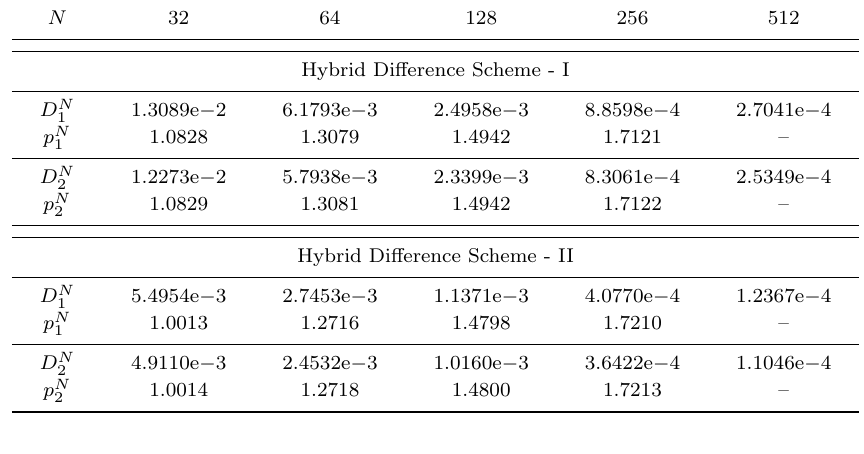
,p N and D N ,p N for the Example 1 in the fine mesh region. 1 1 2 2